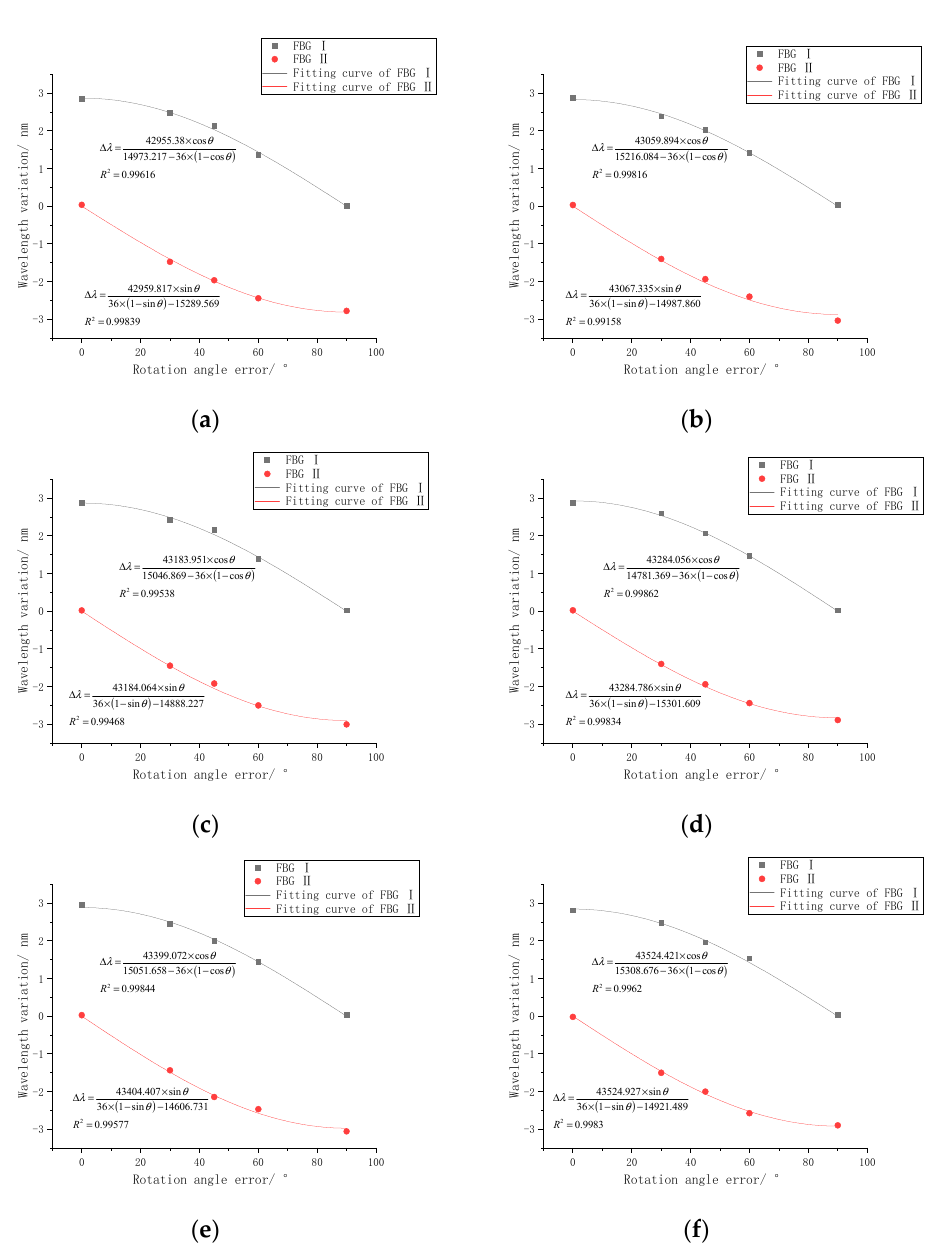
Figure 9. Variation curve of FBG wavelength with rotation error angle (fixed parameters r and M , fitting parameters ρ ). ( a ) Grating 1; ( b ) grating 2; ( c ) grating 3; ( d ) grating 4; ( e ) grating 5; ( f ) grating 6. Table 3. Curvature obtained by fitting and its relative